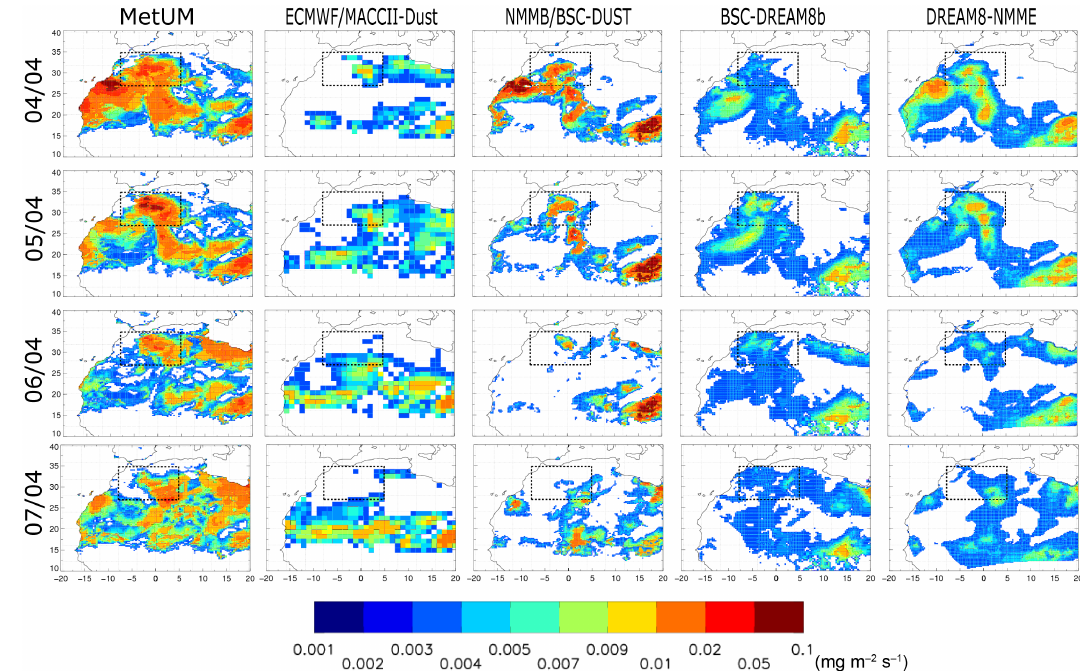
Figure 5. Forecasted daily average emission with 24h lead time for the models MetUM (first column), ECMWF/MACC (second column), NMMB/BSC-DUST (third row), BSC-DREAM8b (forth column) and DREAM8-NMME (fifth row). Dashed box illustrates region used in the time series emissions illustrated in Fig. 6.